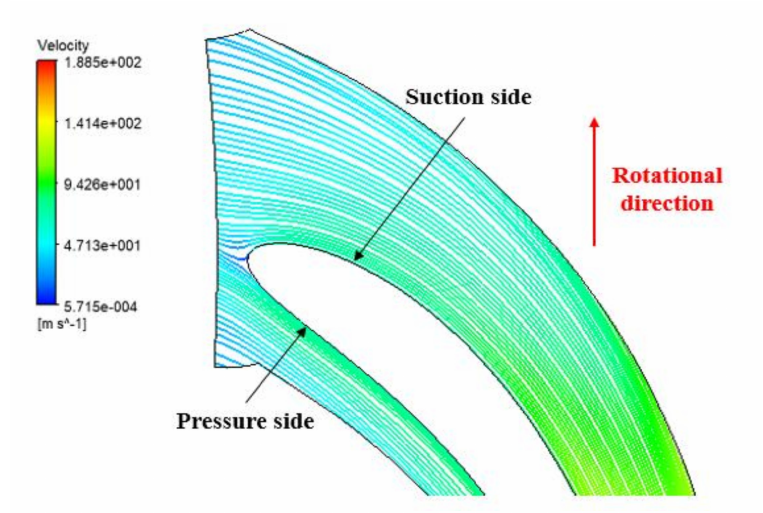
Figure 14. Streamline of the rotor blade (A